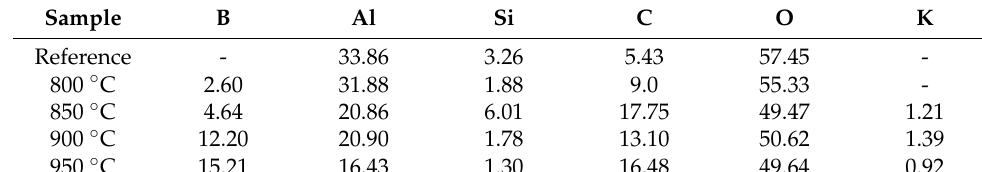
Table 1. Elemental composition of Al 2 O 3 samples’ surface (in at.%, by XPS).